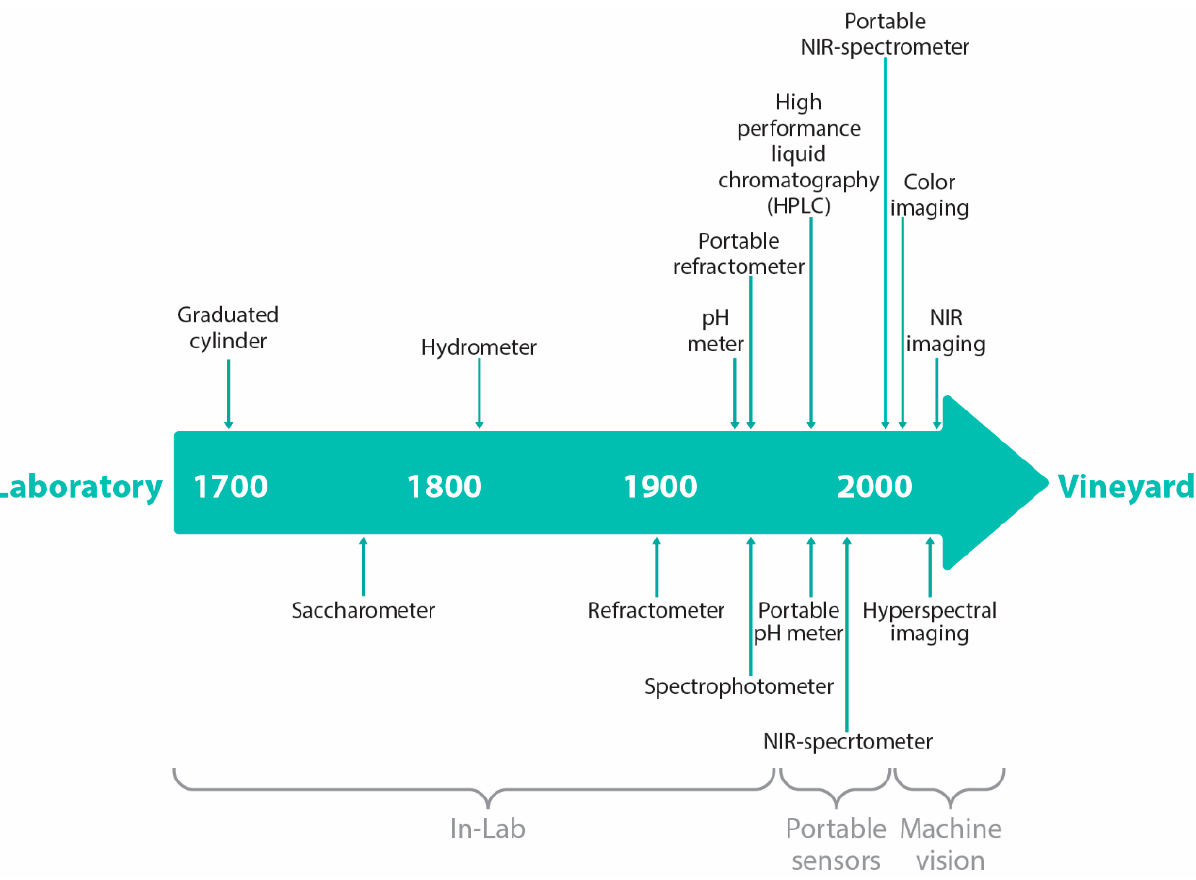
Figure 1. Evolution of grape ripeness estimation techniques.